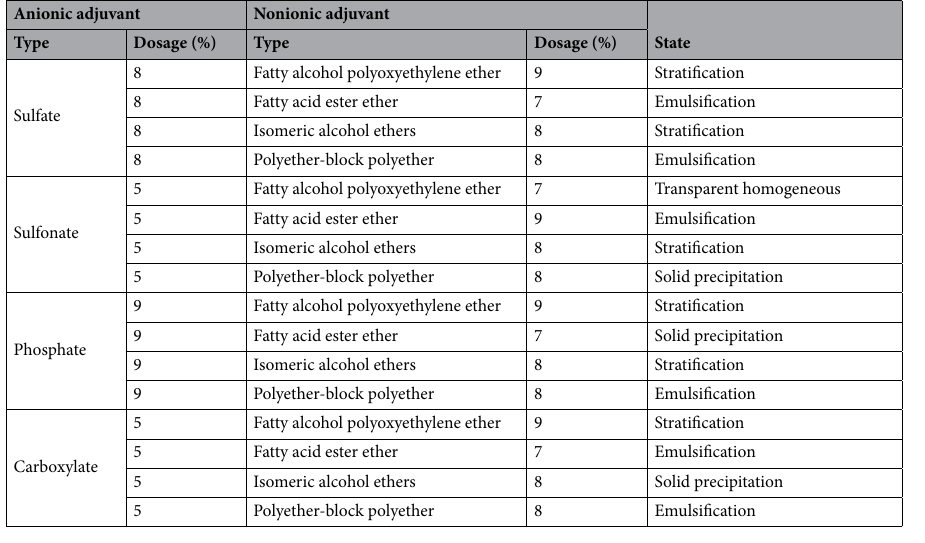
Table 2. Selection of adjuvants type and dosage (%: mass fraction).